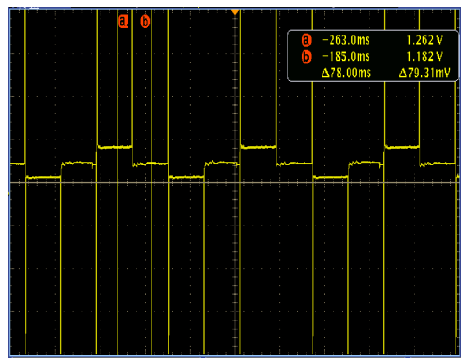
Figure 11. The potential difference between two sensors.